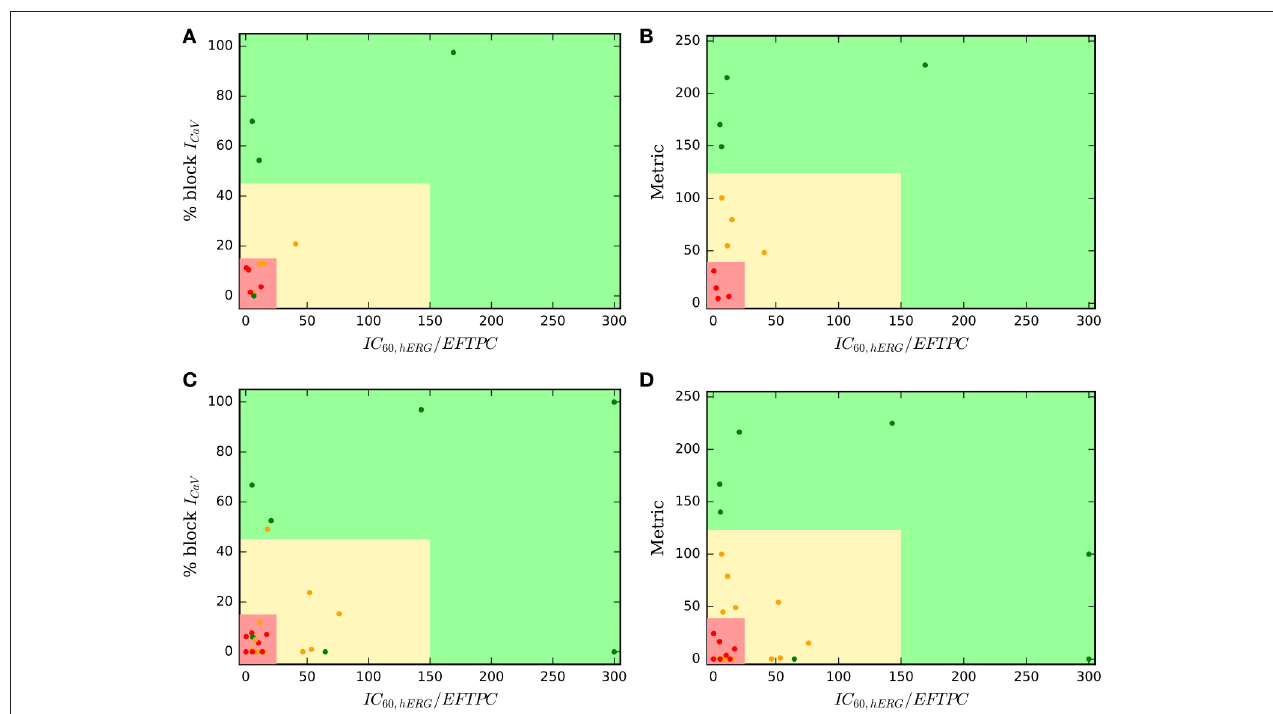
FIGURE 6 | Two-dimensional TdP risk map for Dataset 7 (Li et al., 2017) (A,B) , and drugs in Fermini et al. (2016) (C,D) . The region in green is a low risk region. Yellow region is an intermediate risk region, and the region in red is a high risk area. Red dots ( • ) indicate high risk drugs, green dots ( • ) indicate low risk drugs and orange dots ( • ) indicate intermediate risk drugs. Metric = % block CaV + % block NaL + degree of drug trapping.